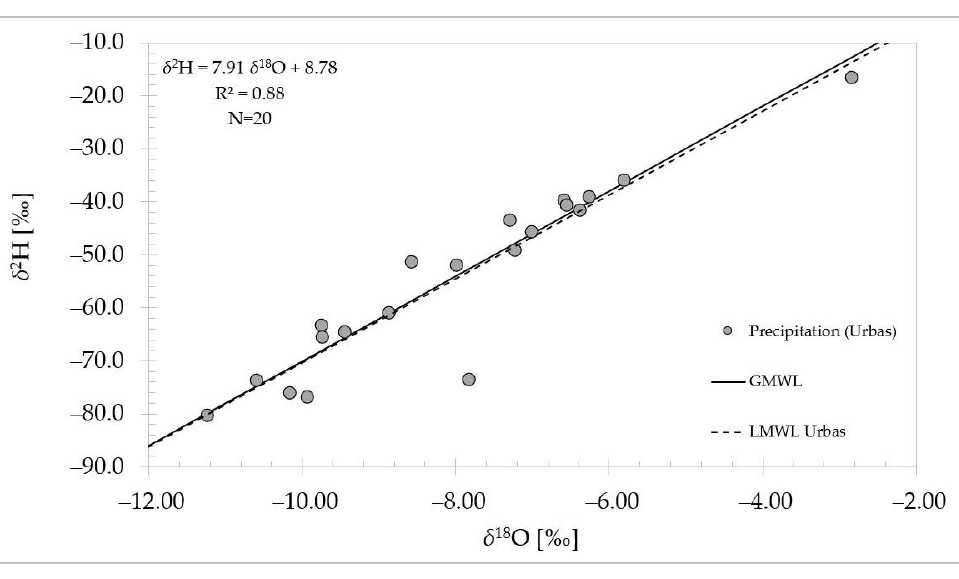
Figure 4. Comparison of the LMWL of Urbas with the LMWL of Kredarica and Zgornja Radovna. In 2018, snow cov er at Javorniški Rovt was present till 7 April in 2019 until 7 May and 2020 till 3 April [30]. The investigated area was influenced by air masses of different